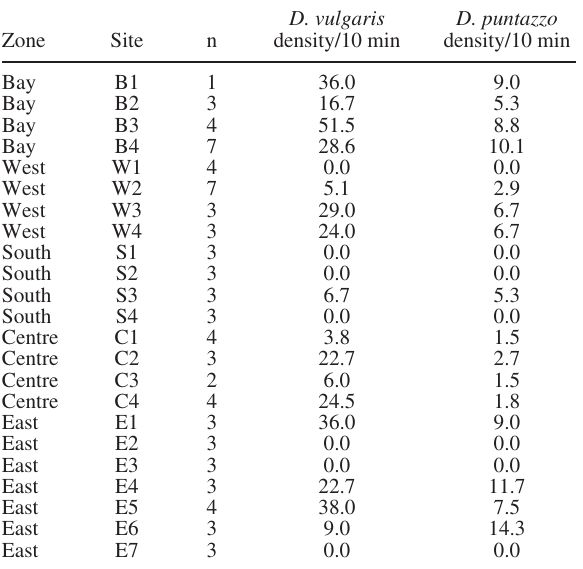
Table 2. – Diplodus vulgaris and D. puntazzo settler densities in the 23 large scale study sites along the rocky shore. Number of 10 minute counts per site (n), settler density per 10 minutes (density/10